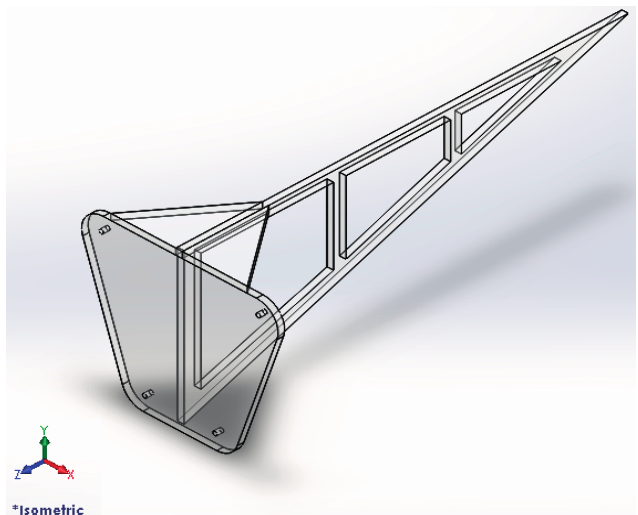
Figure 53. Body design.